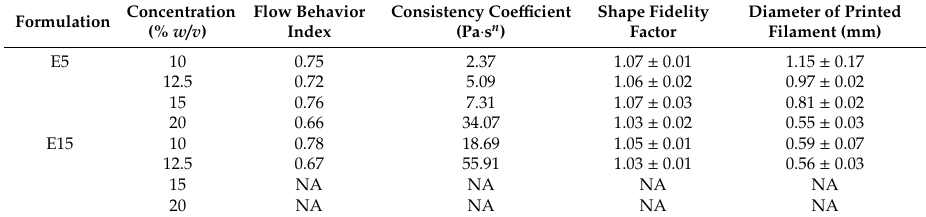
Table 2. Power-law model parameters and shape fidelity factor of di ff erent concentrations of HPMC E5 and HPMC